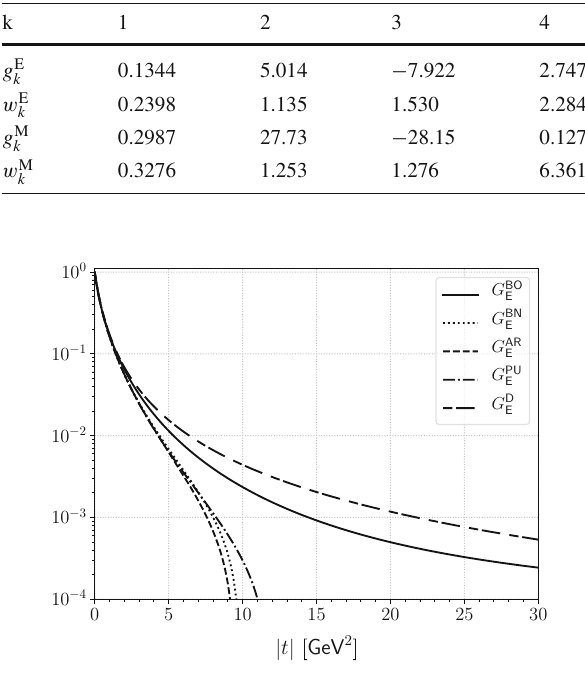
Fig. 13 Proton electric form factors G E ( t